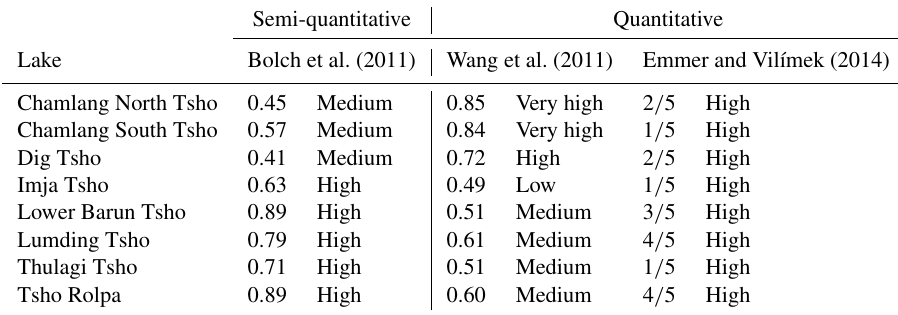
Table 2. Previous semi-quantitative and quantitative hazard assessments applied to eight glacial lakes in Nepal. Values and thresholds for classifications are specific to each study. Fractions are the number of scenarios for each lake that are considered to be highly dangerous. Details shown in Tables